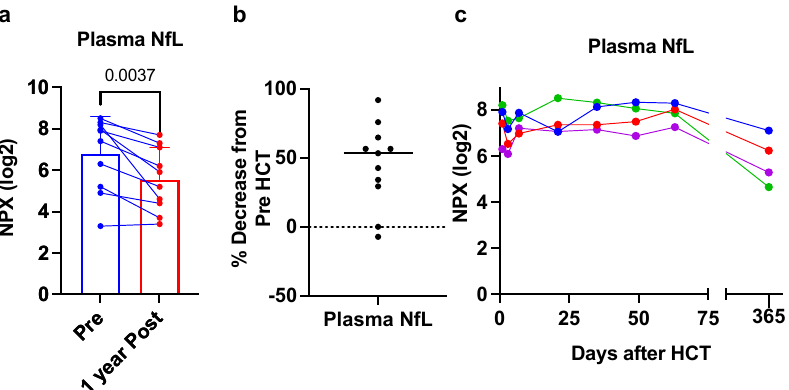
Figure 4. Response of plasma NfL to HCT. ( a ) Eleven paired samples before and 1 year after HCT. p -value from a Student’s paired t -test. ( b ) Decreased plasma NfL. NPX value were converted to linear scale prior to calculating percent decrease. ( c ) Frequent longitudinal plasma samples in four CALD patients after HCT to 365 days post-HCT (Pre-HCT is timepoint 0). Each color represents a unique patient.